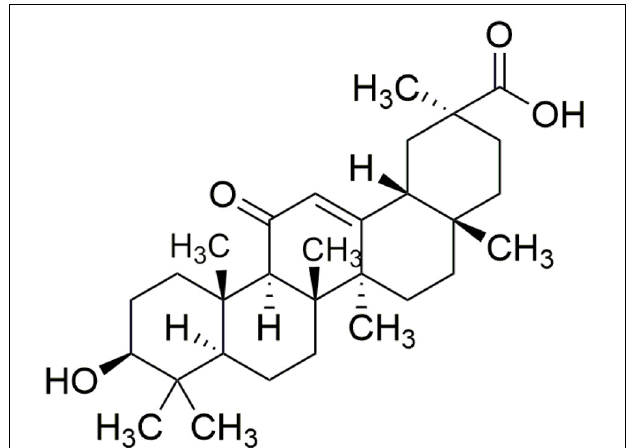
FIGURE 1 | Structure of 18 β -glycyrrhetinic acid. The molecular formula for 18 β -glycyrrhetinic acid is C30H46O4, and the molecular weight is